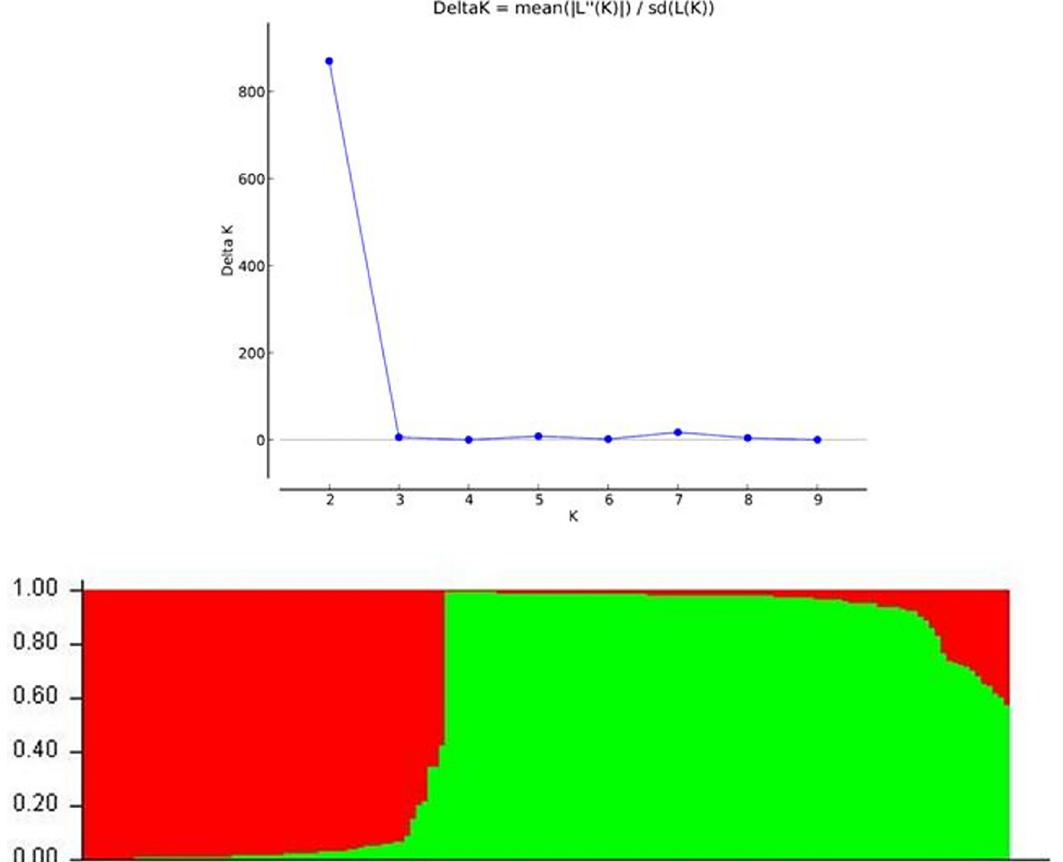
Fig 4. Analysis of molecular variance (AMOVA) and Principal Coordinate Analysis (PCoA) of 161 Indian landraces based on linked/functional